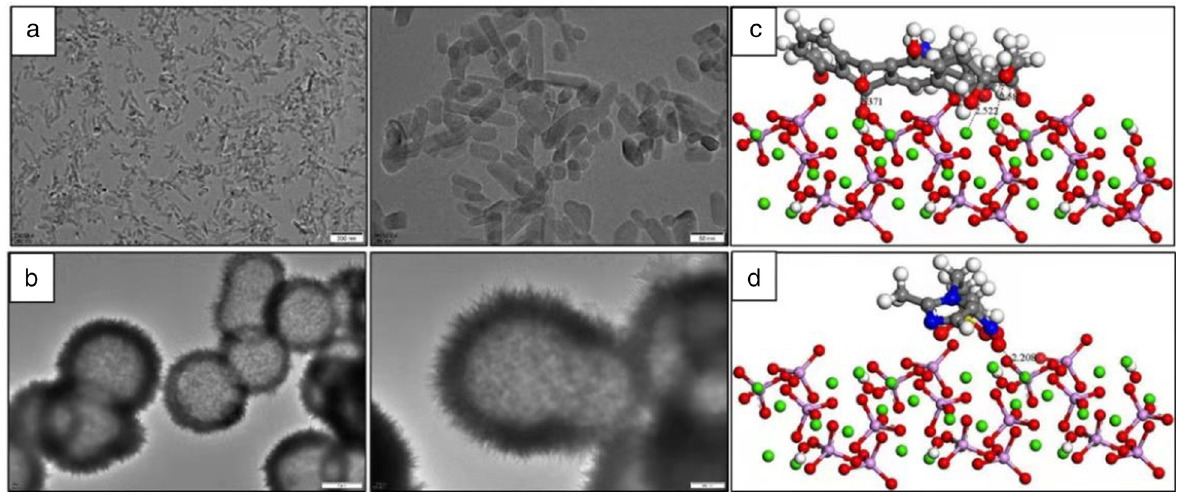
Figure 2: ( a and b ) TEM micrographs of the as - prepared HA. ( a ) HA nanoparticle, ( b ) HA hollow microsphere. ( c and d ) Adsorption con fi g - urations of DOX ( c ) and tinidazole ( d ) on the ( 110 ) plane of HA. The colors are as follows: calcium ( green ) , phosphorus ( purple ) , oxygen ( red ) , hydrogen ( white ) , carbon ( gray ) , nitrogen ( blue ) , and sulfur ( yellow ) [ 47 ]